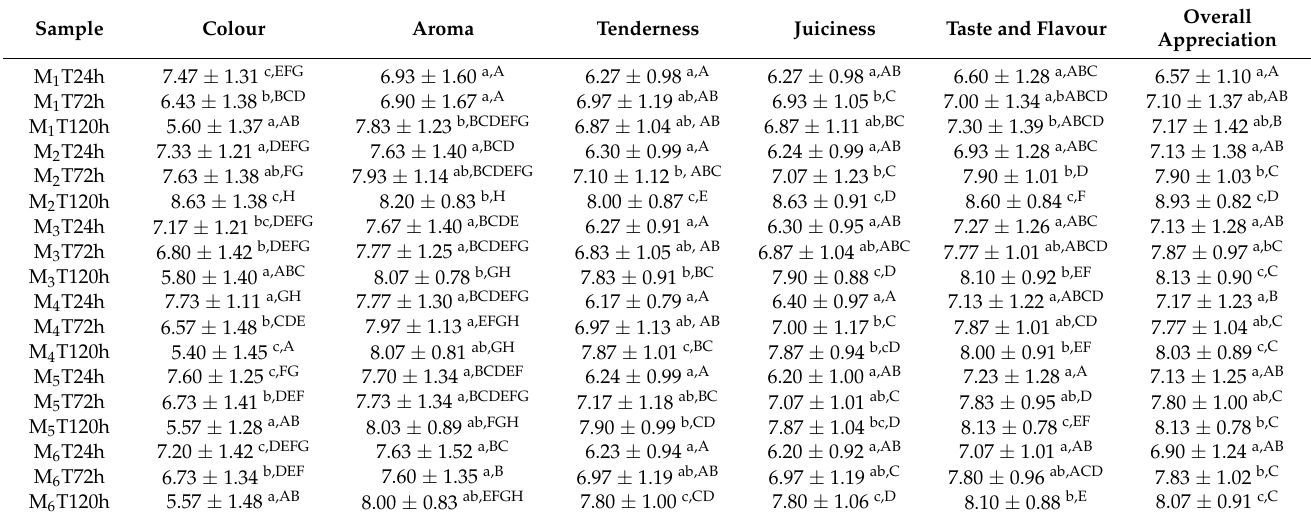
Table 11. Hedonic scores for analysed